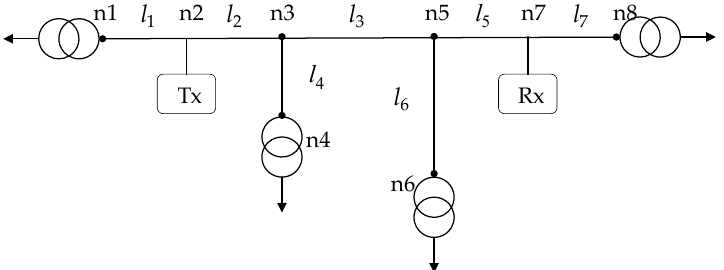
Figure 2. Example of the medium-voltage radial distribution network containing the power-line communication transmitter (Tx) and receiver (Rx).